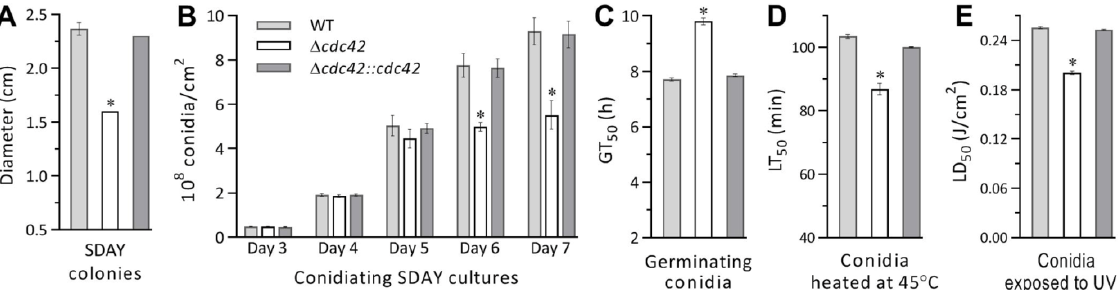
Figure 1. Role of cdc42 in the asexual cycle in vitro of B. bassiana . ( A ) Diameters of SDAY colonies incubated for 7 days after initiated with ~10 3 conidia at the optimal regime. ( B ) Conidial yields measured from the SDAY cultures during a 7 day incubation after initiated by spreading 100 µ L aliquots of a 10 7 conidia/mL suspension at the optimal regime. ( C – E ) GT 50 (h), LT 50 (min), and LD 50 (J/cm 2 ) estimates as the respective indices of conidial quality for the time length of 50% germination at 25 ◦ C, tolerance to a wet-heat stress at 45 ◦ C and resistance to UVB irradiation. * p < 0.05 in Tukey’s HSD tests. Error bars: SDs from three replicates.